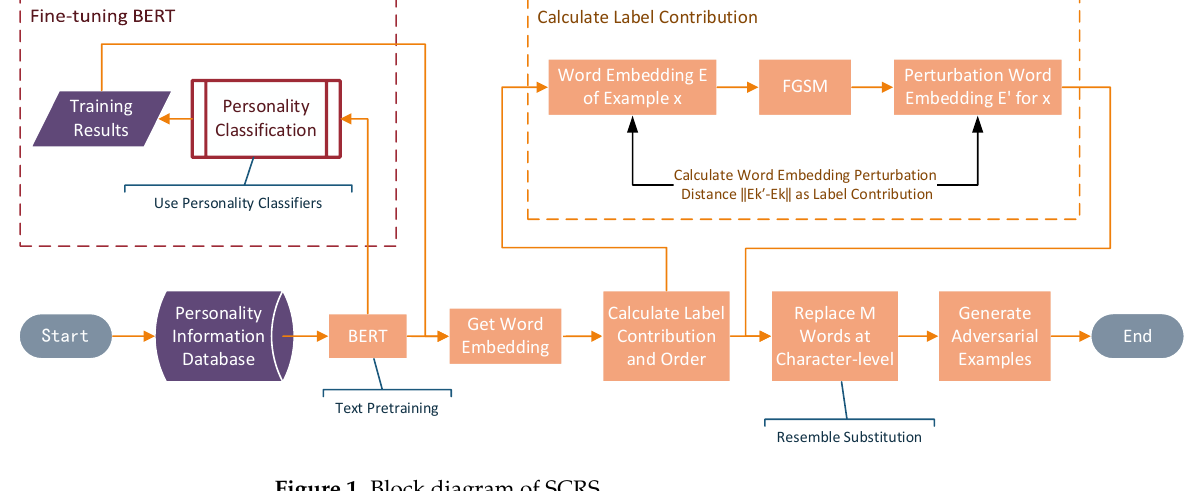
Figure 1. Block diagram of SCRS.